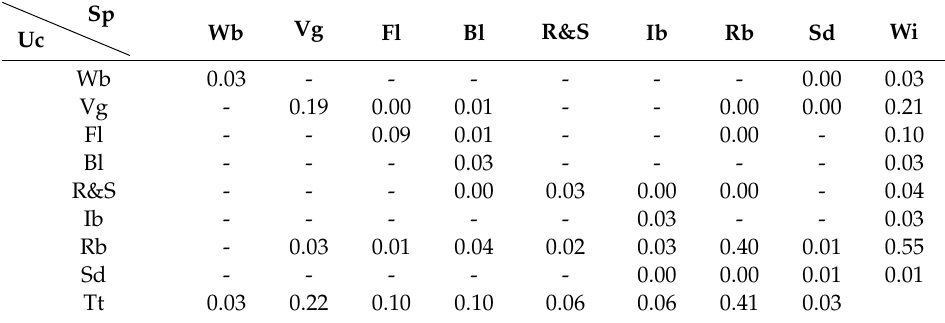
Table 6. The error matrix populated by estimated proportion of area for ULULC layer